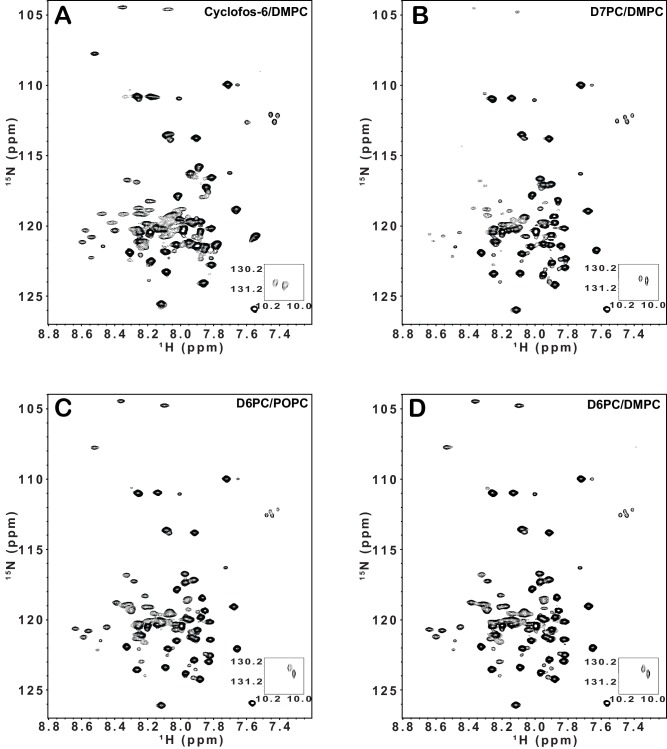
900 MHz 1H,15N-TROSY spectra of integrin β1 TM/CT.900 MHz 1H,15N-TROSY spectra of integrin β1 TM/CTat 45o C in four different bicelle mixtures: (A) Cyclofos-6/DMPC, (B) D7PC/DMPC, (C) D6PC/POPC, (D) D6PC/DMPC. The NMR samples contain ~500 µM β1 TM/CT, 20% q = 0.3 bicelles, 1 mM EDTA, 250 mM IMD, at pH 6.5, with 10% D2O.